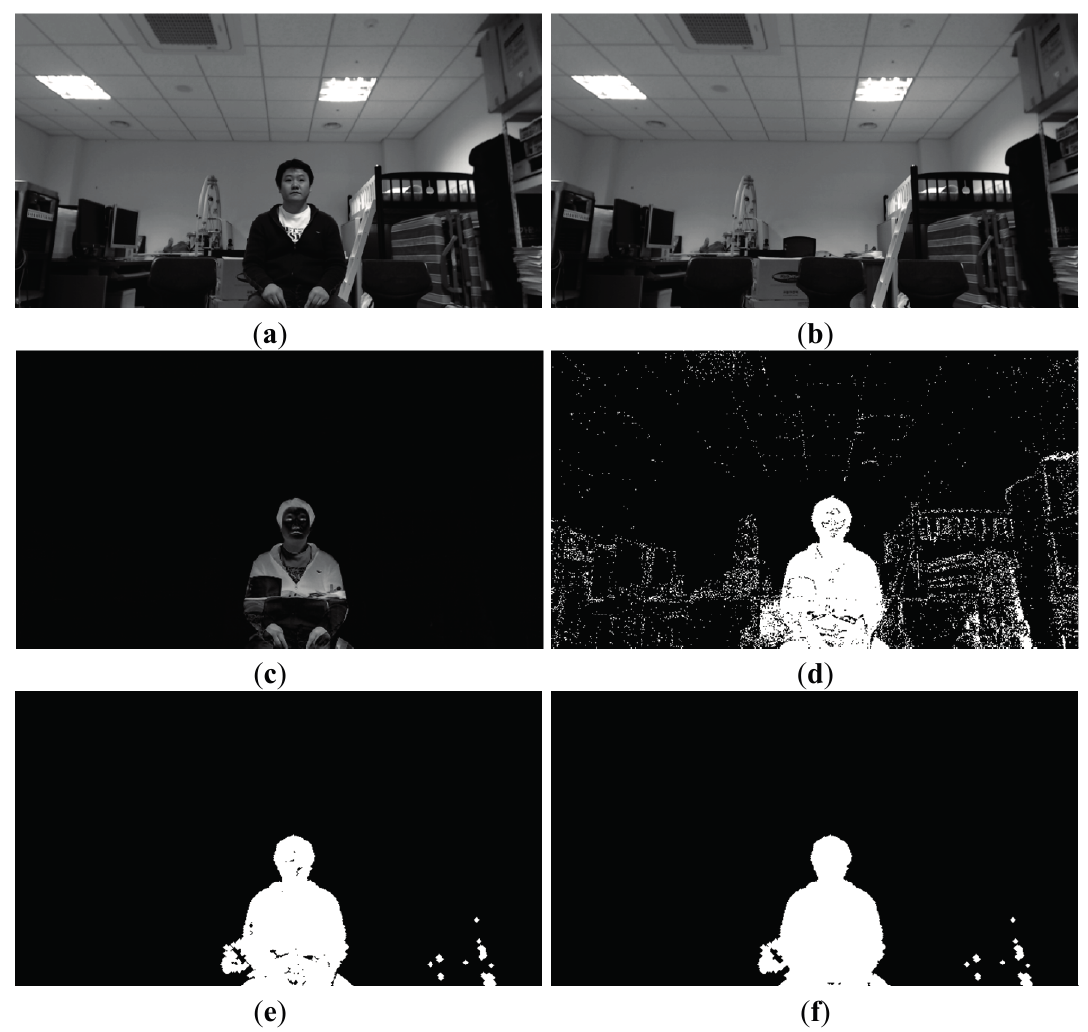
Figure 3. Examples illustrating segmentation of the user area: ( a ) Input image; ( b ) Background image; ( c ) Difference image obtained from (a) and (b); ( d ) Binary image of (c); ( e ) Image after morphological operation; ( f ) Image obtained by filling holes in